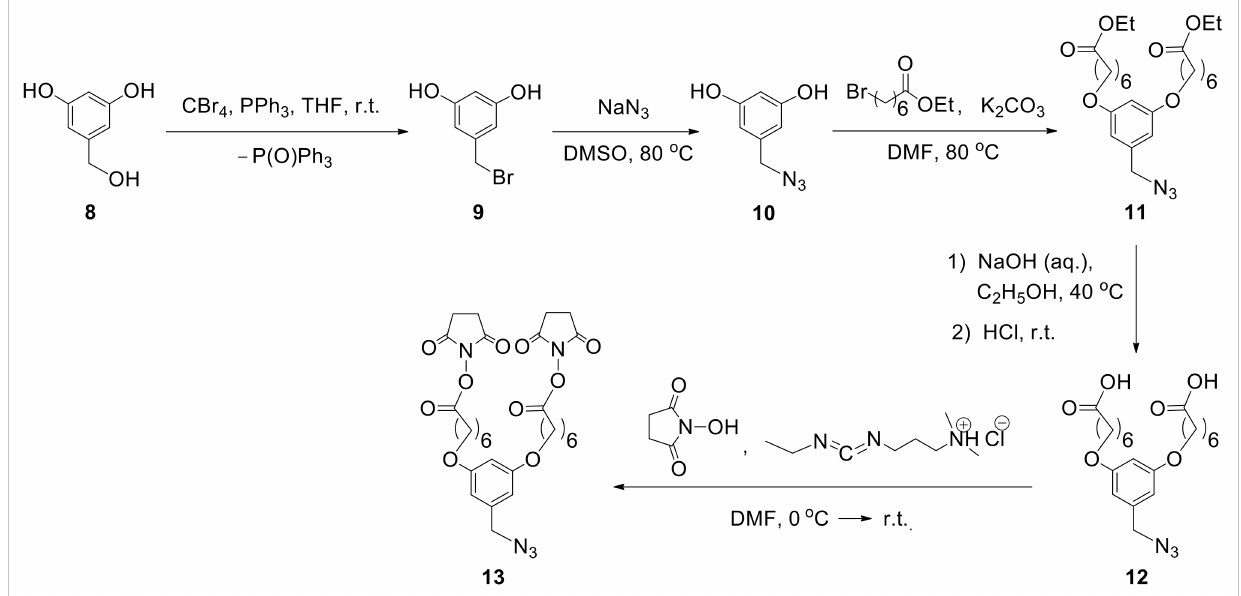
Figure 9. The sequence of transformations of 3,5-dihydroxybenzyl alcohol ( 8 ) to target azide 13